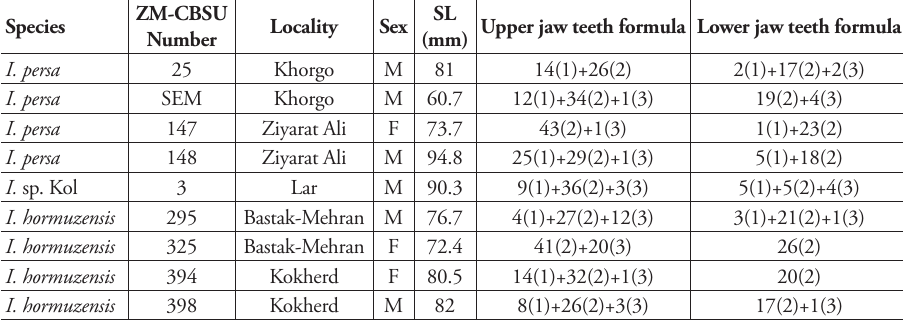
Table 4. Teeth formula of Iranocichla . 1 = unicuspid; 2 = bicuspid; 3 = tricuspid.